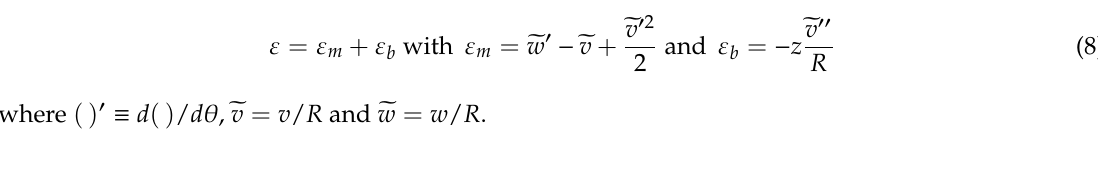
Figure 2. Schematic configuration of the functionally graded graphene nanoplatelet-reinforced composite (FG-GPLRC) arch.